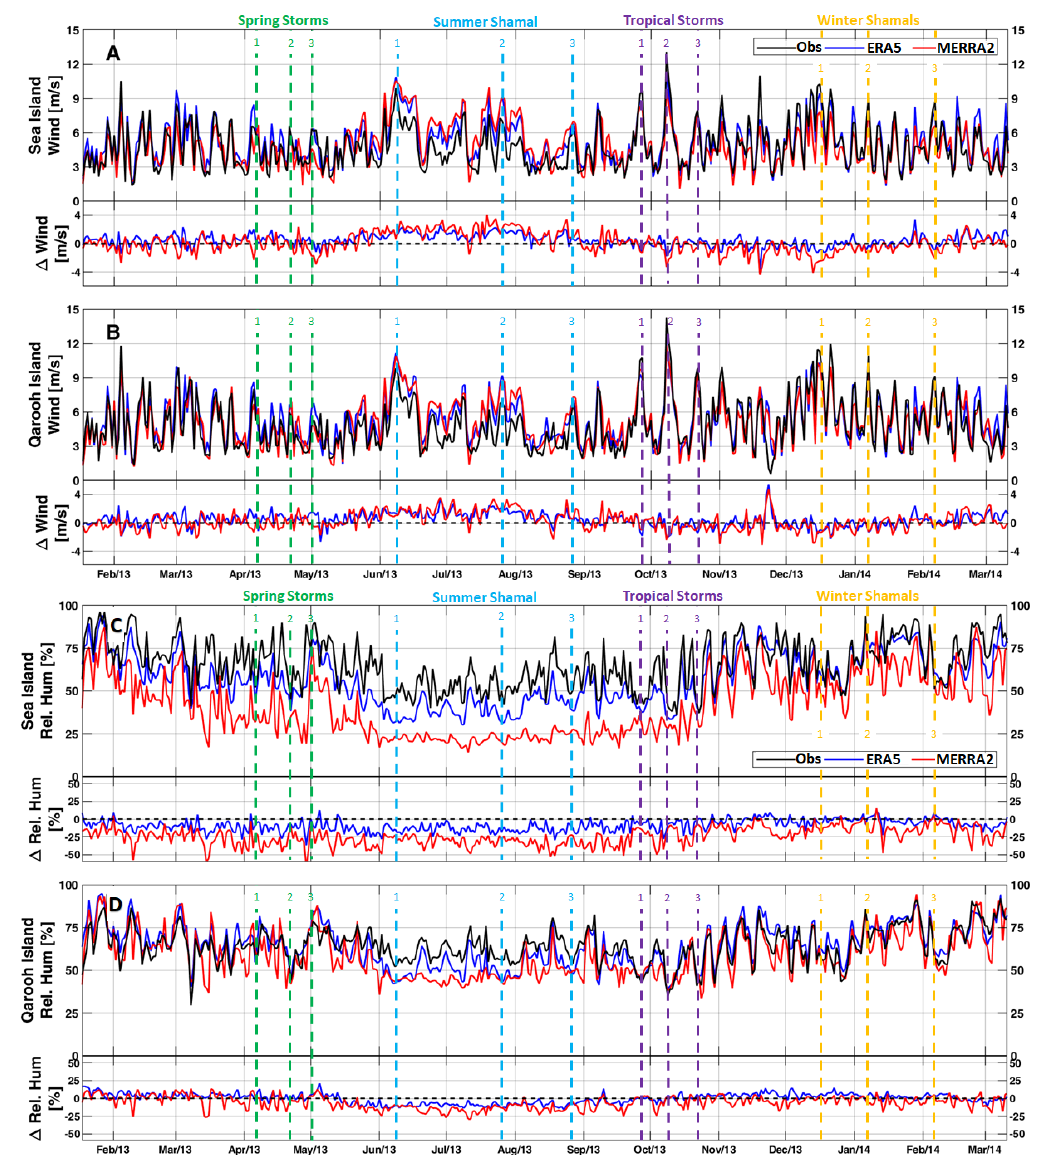
Figure 4. Daily average wind speed ( A , B ) and relative humidity ( C , D ) derived from reanalysis products (ECMWF-ERA5 blue and NASA-MERRA2 red) and observations (black). Differences can be seen at the Sea Island and Qarooh Island stations. Positive differences indicate overestimates, and vertical dashed lines indicate spring wind events (green), summer Shamals (blue), tropical storms (magenta), and winter Shamals (orange). ∆ Wind ( A ) and ∆ Rel . Hum ( B ) represent the difference between reanalysis products and